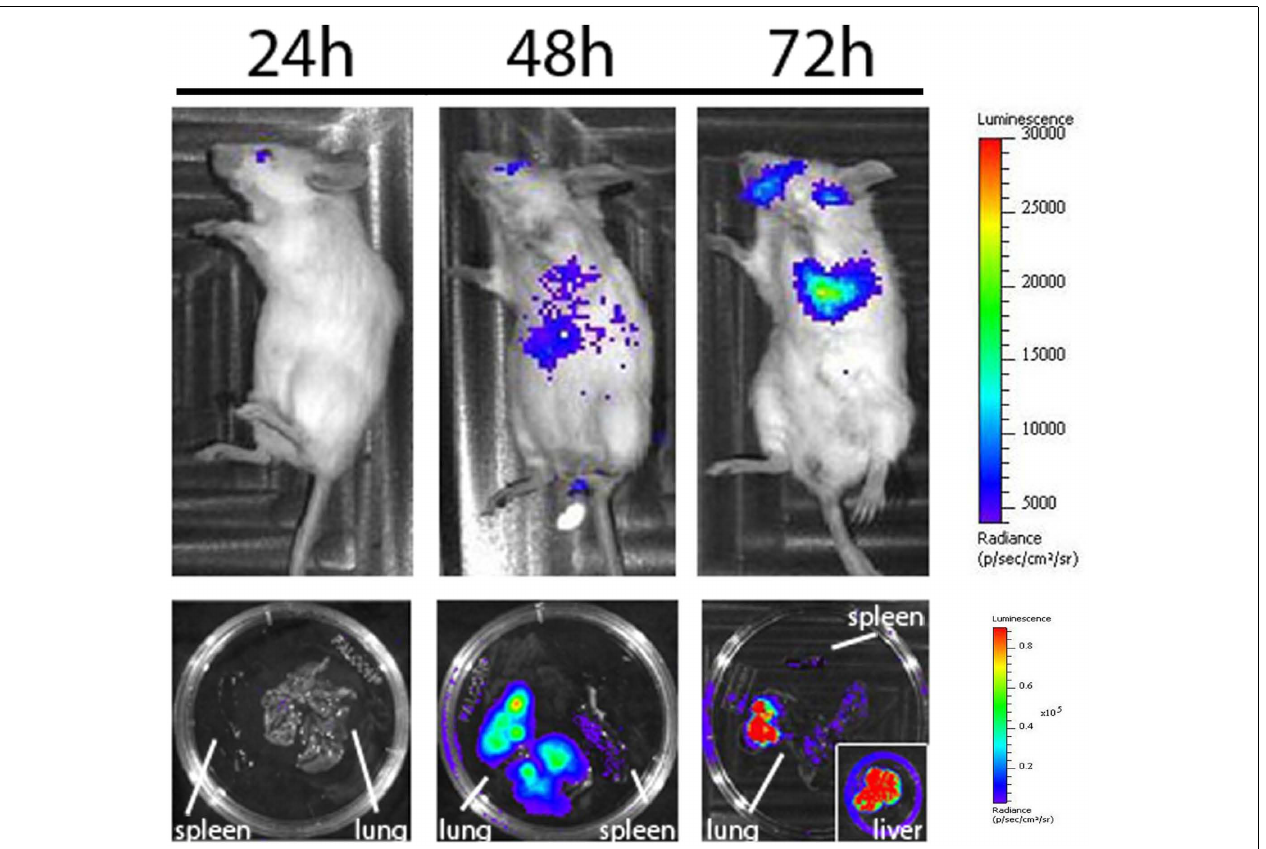
pseudocolor image. At each time point, an animal was sacrificed and organs were harvested for ex vivo imaging and bacterial load determination. Images are representative of four replicate